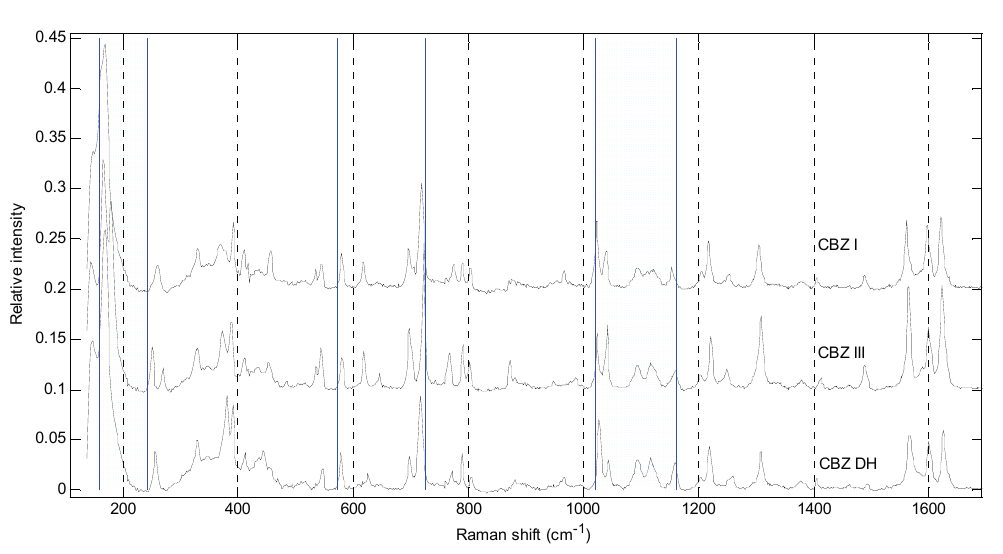
Figure 2. Raman spectra of pure samples with excipients: (a) CBZ I, (b) CBZ III, (c) CBZ DH. In blue, the ranges selected by the best iPLS model, in cm − 1 : 160 to 244; 572 to 726; and 1021 to 1162.